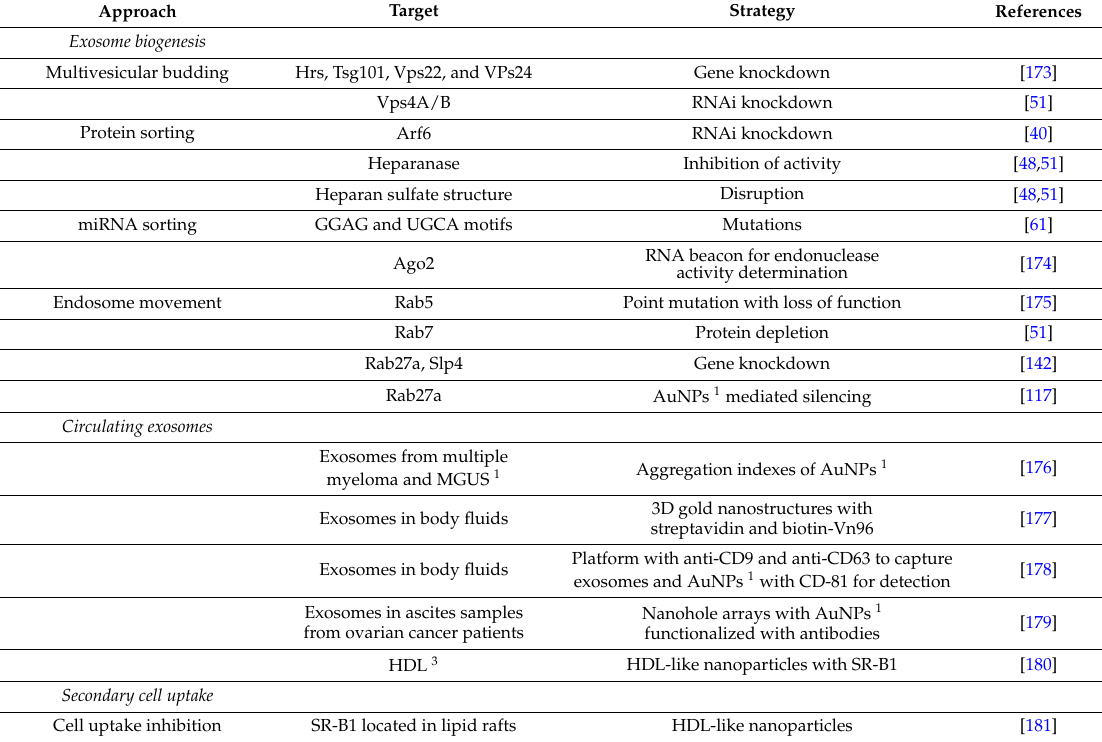
Table 1. Compilation of silencing and targeting strategies used for inhibition of malicious exosomes’ biogenesis, exosomes’ uptake by secondary cells, and detection of circulating malicious